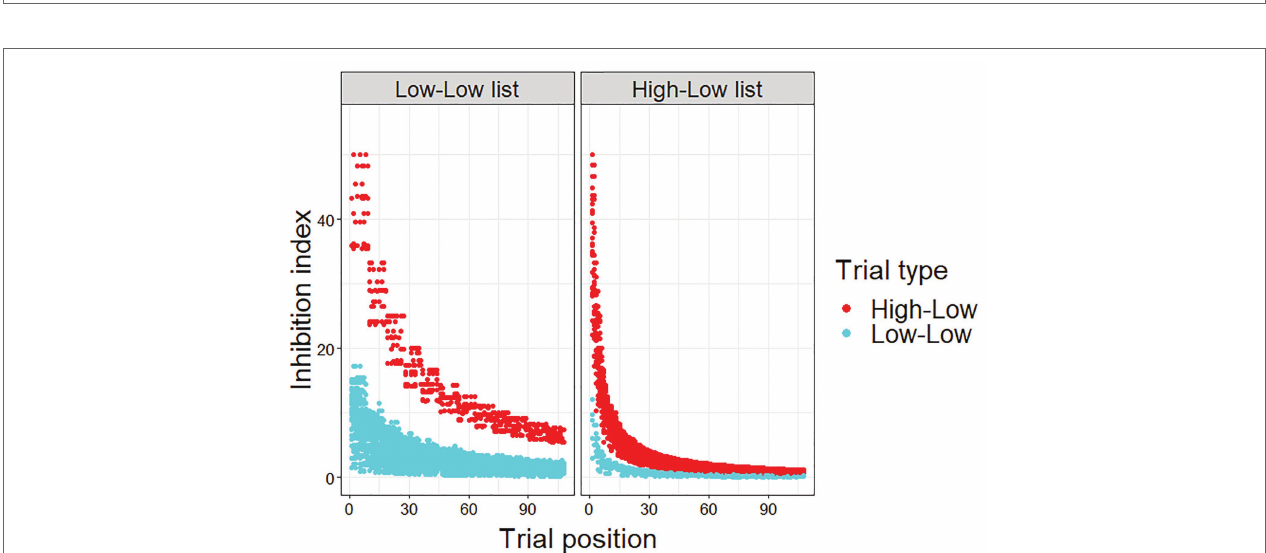
FIGURE 1 | Reaction times in the critical trials in Experiment 1.